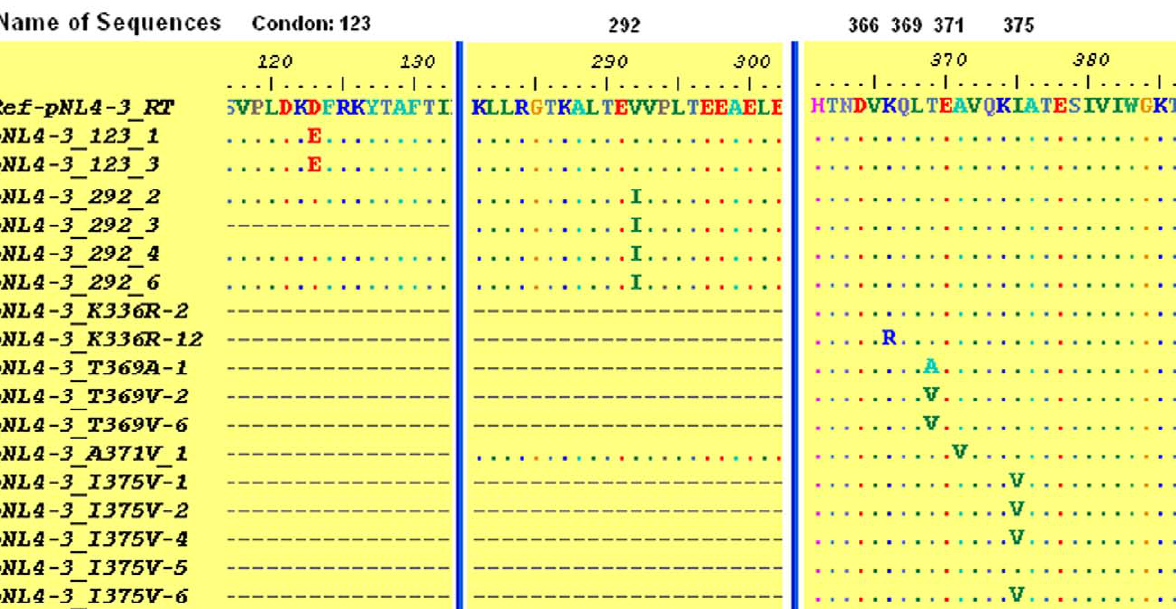
Note: a R indicated mutations that could confer resistance to antiviral drugs, and b U indicated mutations which confers an unknown response to antiviral drugs. doi:10.1371/journal.pone.0047119.t002 constructed viruses The TCID50 of each constructed mutant virus was more than 10 3 , suggesting sufficient viral titer for subsequent experiments.